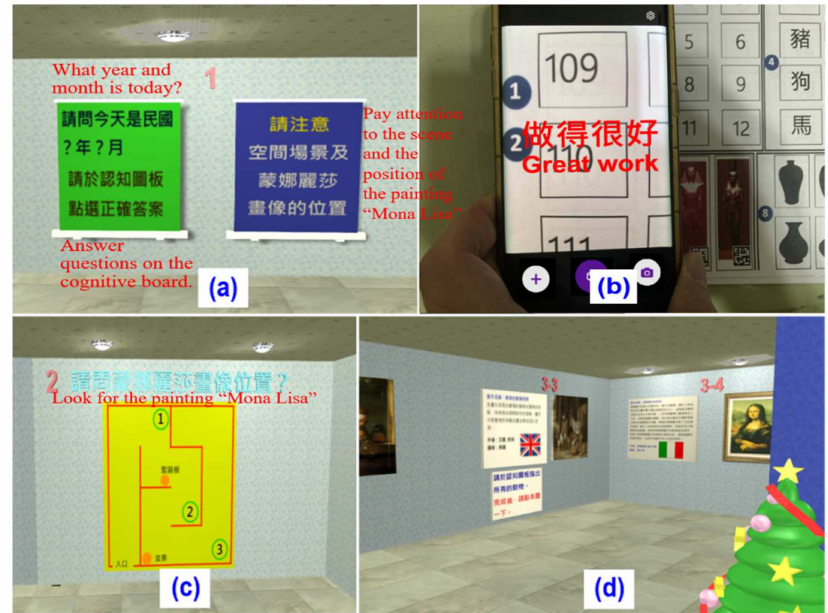
Figure 4. Orientation test screen: ( a ) Date questions in time orientation test; ( b ) Using mobile phone AR to answer date questions; ( c ) Instructions for looking for a specific painting “Mona Lisa”; ( d ) Location of the specific painting “Mona